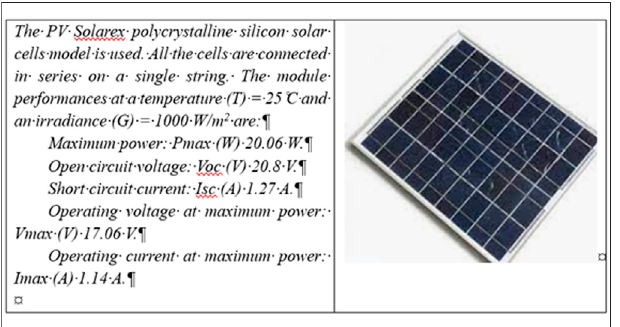
FIGURE 1 | Characteristics of selected solar